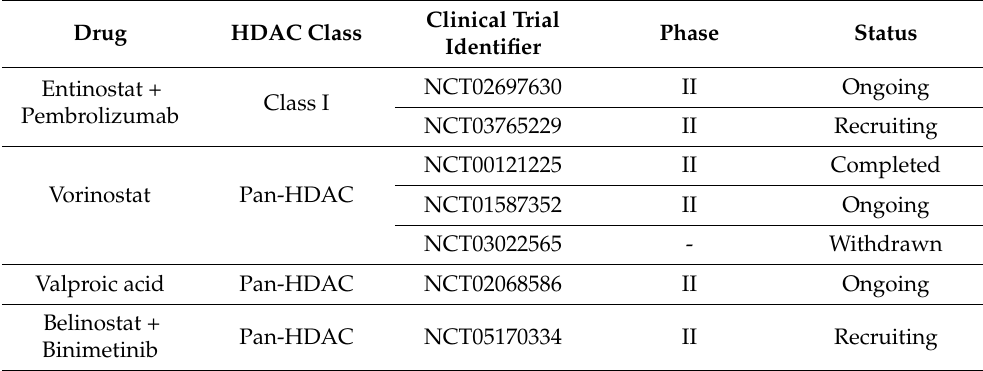
Table 1. HDAC inhibitors in clinical trial for UM and advanced